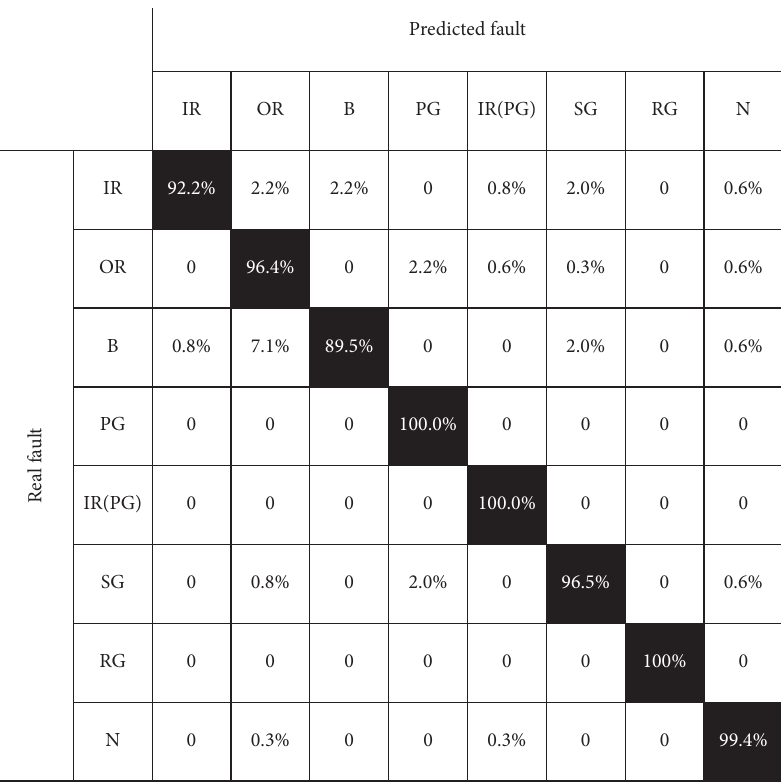
Figure 8: Confusion matrix of classification result with the original signal and CNN. IR represents bearing inner race fault; OR represents bearing outer race fault; B represents bearing ball fault; PG represents planet gear fault; IR (PG) represents that bearing in the gearbox has an inner race fault; SG represents sun gear fault; RG represents ring gear fault; and N represents no fault. Table 4: Fault diagnosis accuracy of test set